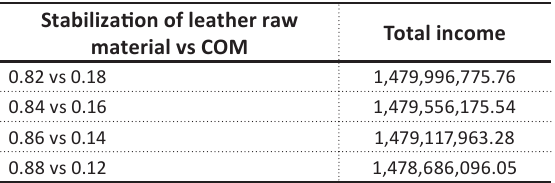
Table 7. Total IKU revenue on scenario 3.2 based